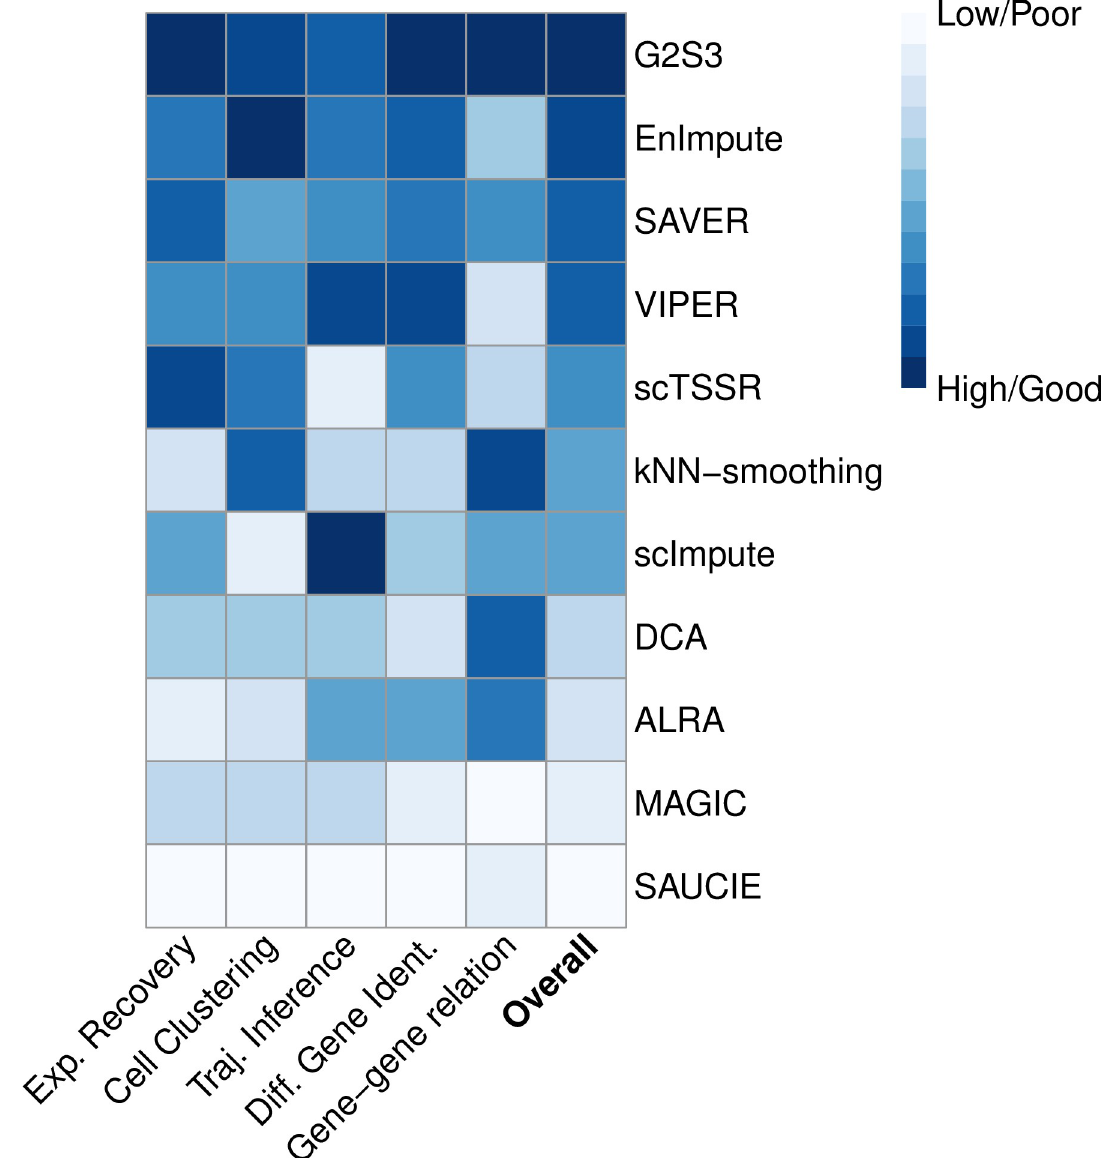
Fig 7. Summary of performance of G2S3 and other imputation methods. A heatmap demonstrating method performance based on the five evaluation criteria. The left five columns display performance rank using each of the five evaluation criteria. The rightmost column displays the overall performance rank based on the sum of the five